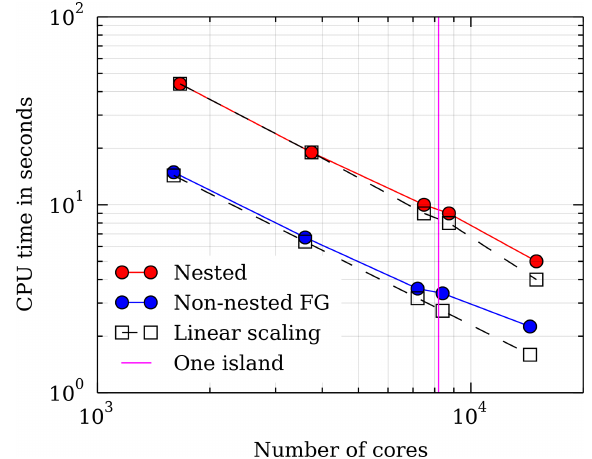
Figure 10. The nested simulations show close to linear scalabil- ity. A non-nested domain with same number of grid points as the FG is plotted to benchmark the scalability of the standard version of PALM on the same machine. The difference between the blue and the red line is approximately equal to the additional computa- tional time needed by the nesting routines. The simulations were performed on SuperMUC at the Leibniz Supercomputing Centre. Each node has 32GB of main memory and two Sandy Bridge pro- cessors with 2.7GHz; each processor has eight cores (Anastopoulos et al.,